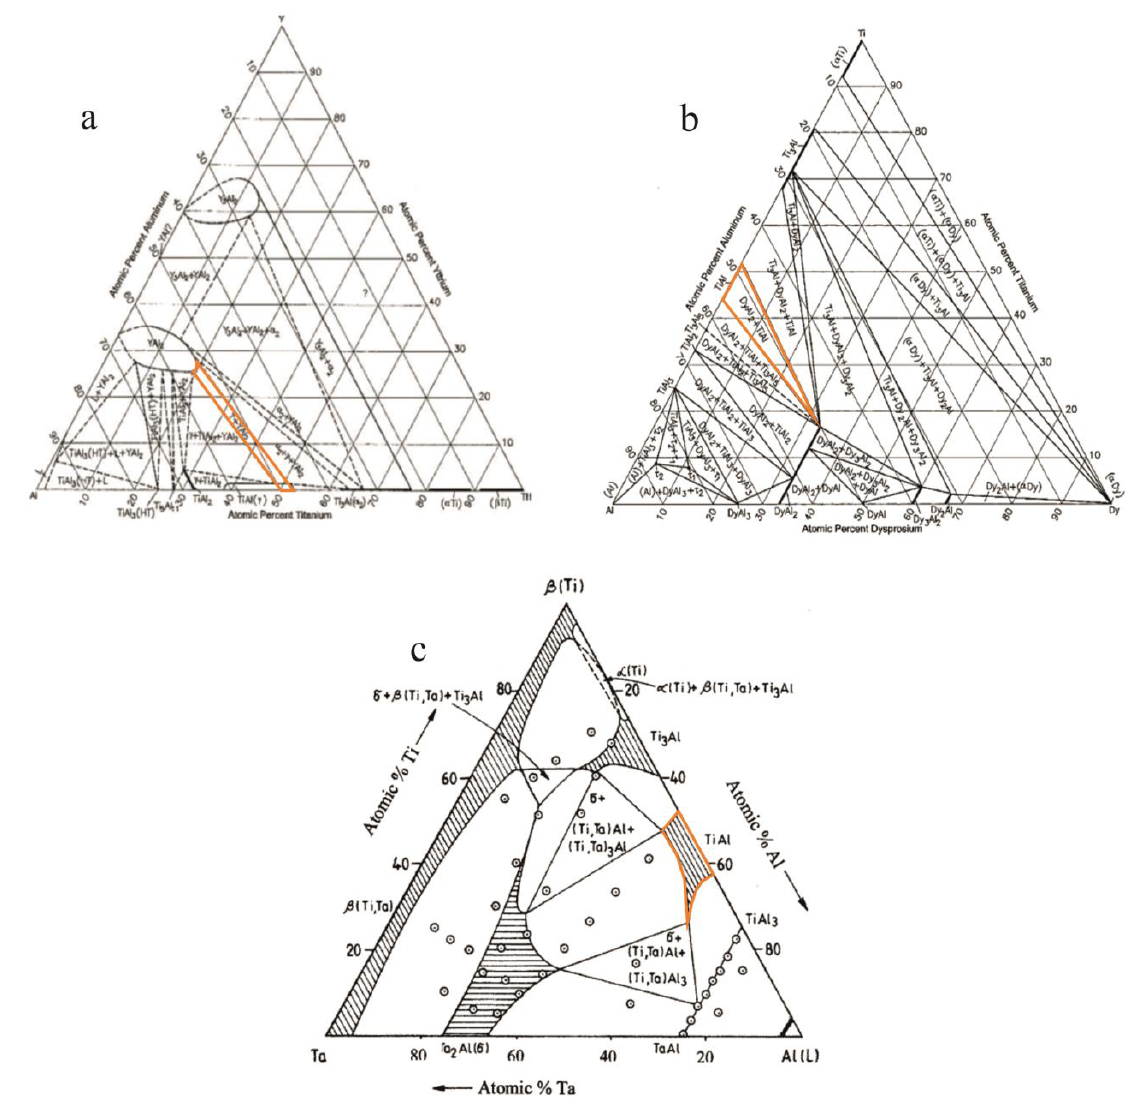
Figure 5. Isothermal cross-sections of the TiAlY system at 1000 °С [45] ( a ), of the TiAlDy system at 500 °C [46] ( b ), of the TiAlTa system at 1100 °C [47] ( c ).